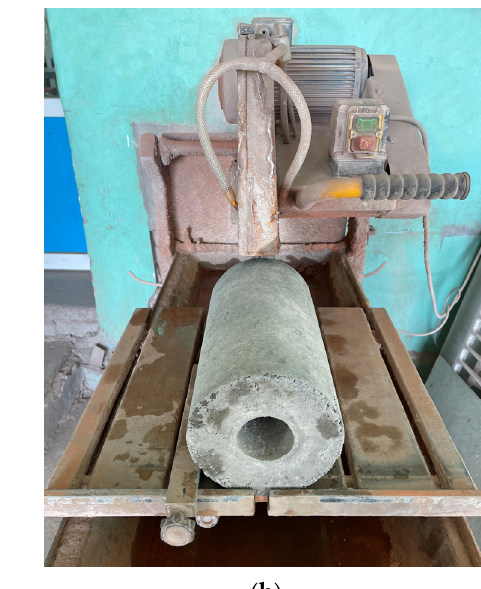
Figure 3. High-precision stone-cutting machine: ( a ) side view; ( b ) top view.